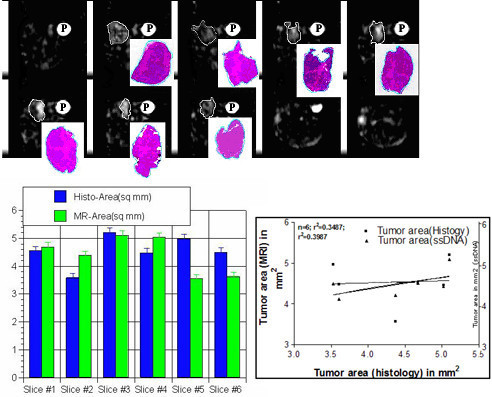
Comparison of delineated feature areas on intracellular sodium [Na]i images and histology digital images is shown at different levels for contiguous IR sodium MR slices (top row) and corresponding histology digital maps next to phantom (P). At bottom, each left bar represents histological area and each right bar represents delineated tumor area on both [Na]i image and histology digital images at different slice levels as shown in Table 5. Quantification of tumor area was done by Optimas 6.5 using sodium MRI and histology digital images. The tumor area was measured in mm2 in one representative tumor shown in Figure 8. Tumor area was measured and correlated in contiguous 6 histology sections with matched IR images (r2 = 0.3487) and scanned ss-DNA mAb digital images in mm2 (r2 = 0.3987). ss-DNA densities in arbitrary units were measured at different locations of the tumor digital images as shown in Figure 5.